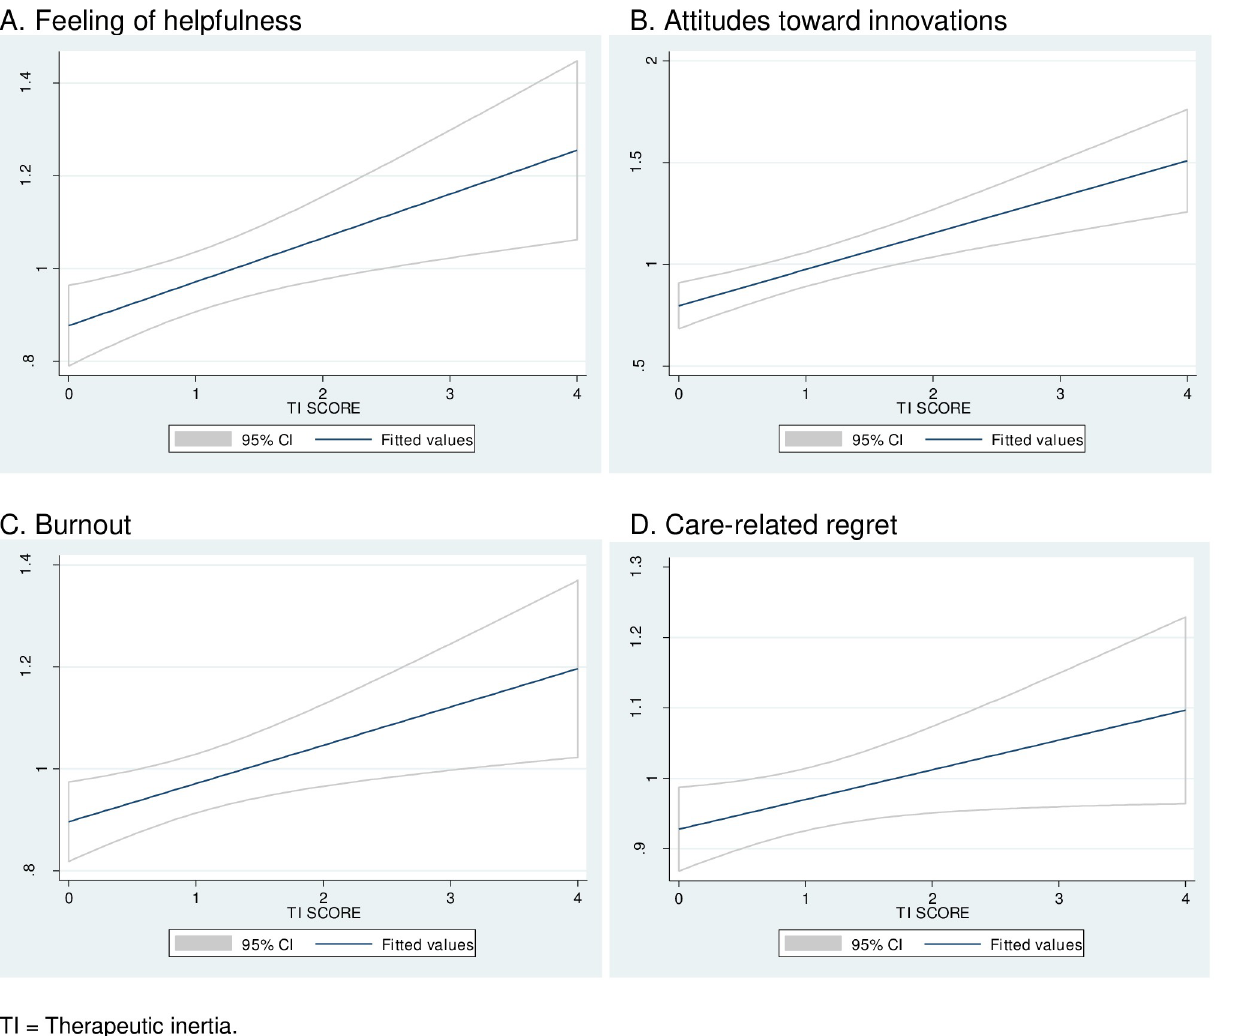
Fig 2. Observed versus predicted probability of therapeutic inertia by behavioral variables of